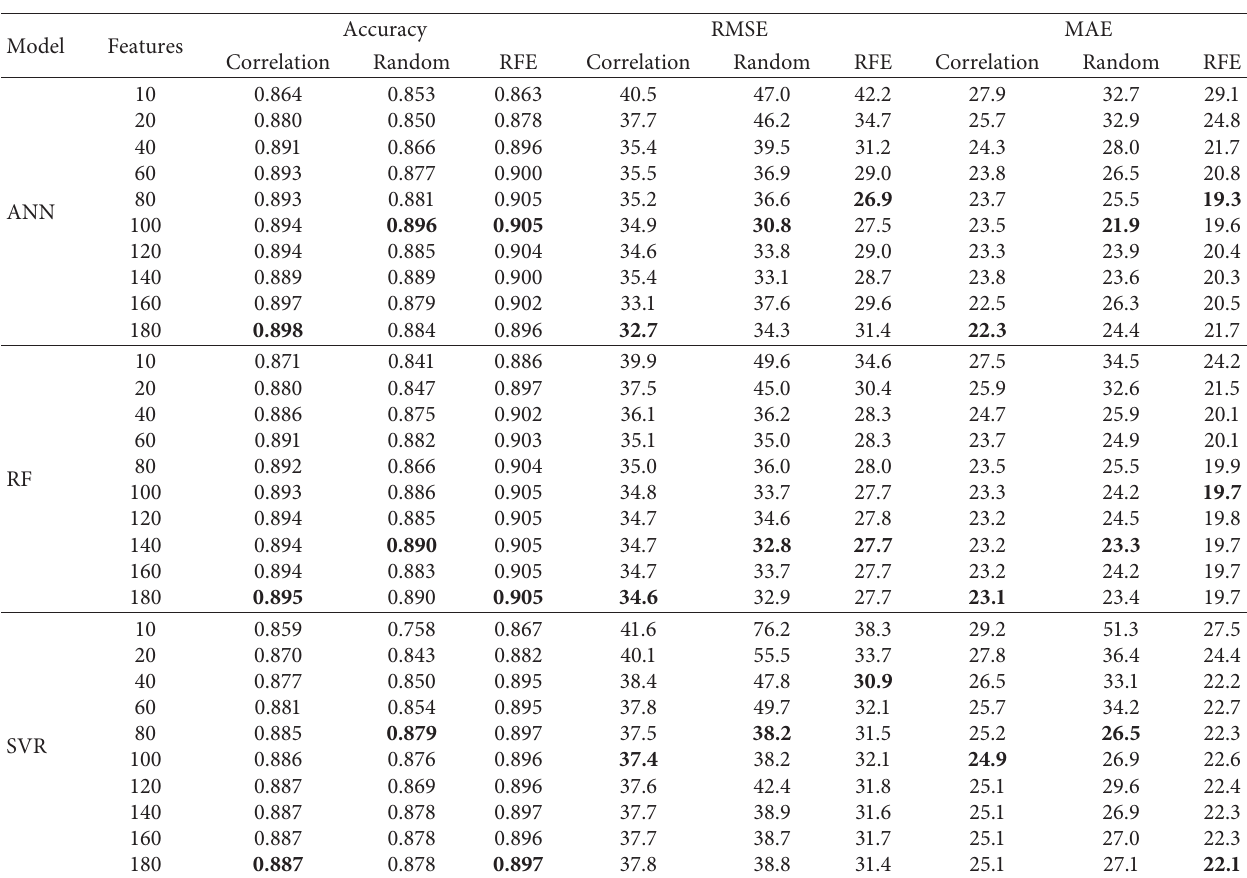
Table 7: Comparison of feature selection methods; traffic volume predictions under all conditions with 30sec input data; given a constrained number of features, in most cases, the RFE method achieves better performance compared to random and correlation-based feature